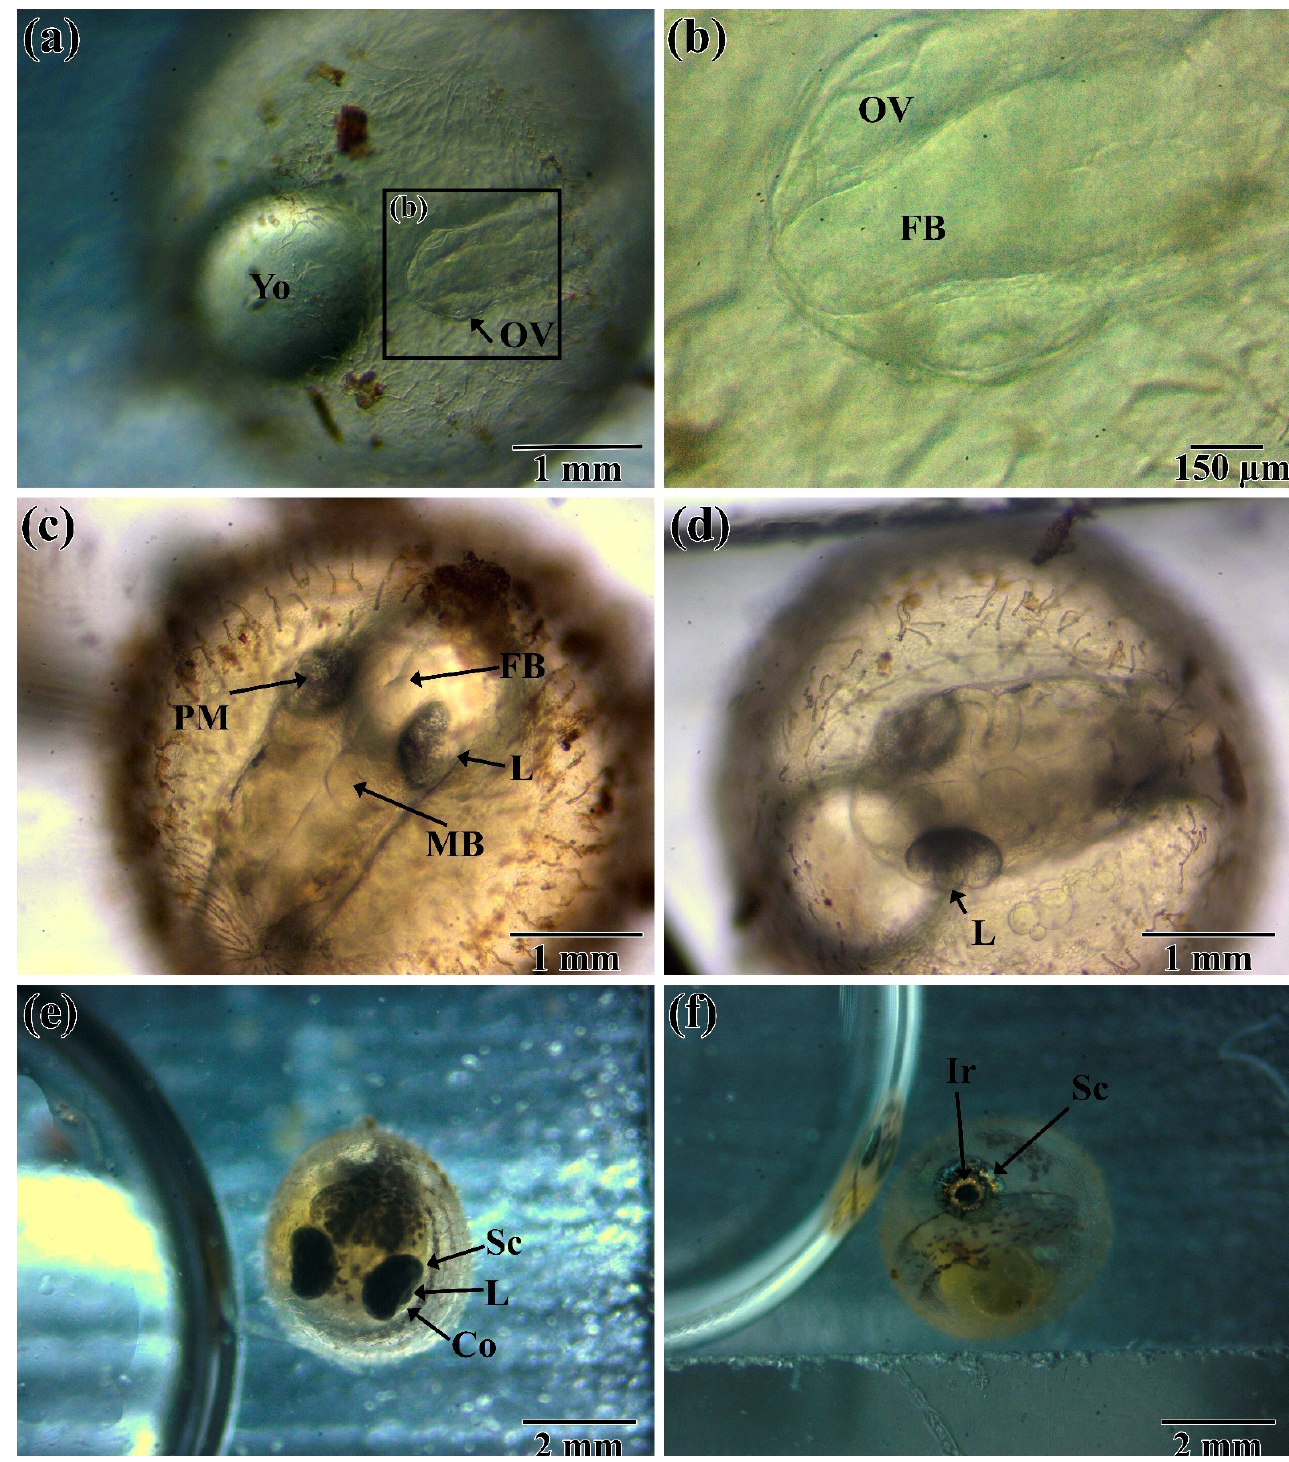
Figure 2. Embryonic development of the visual system of N. guentheri in the period from 26 hpf to 21 dpf: ( a , b ) 26 to 28 hpf, early neurula, ocular vesicle formation; ( c , d ) 96 hpf to 7 dpf early somitogenesis (6–12 somites); ( e ) 10 to 12 dpf retina pigmentation (30–35 somites); ( f ) 21-n dpf stage before hatching (duration depends on the course of diapause). Yo—yolk; Ov—optic (eye) vesicle; FB—forebrain; L—lens; MB—mid-brain; PM—Periocular Mesenchyme; SC—sclera; CO—cornea; IR—iris.